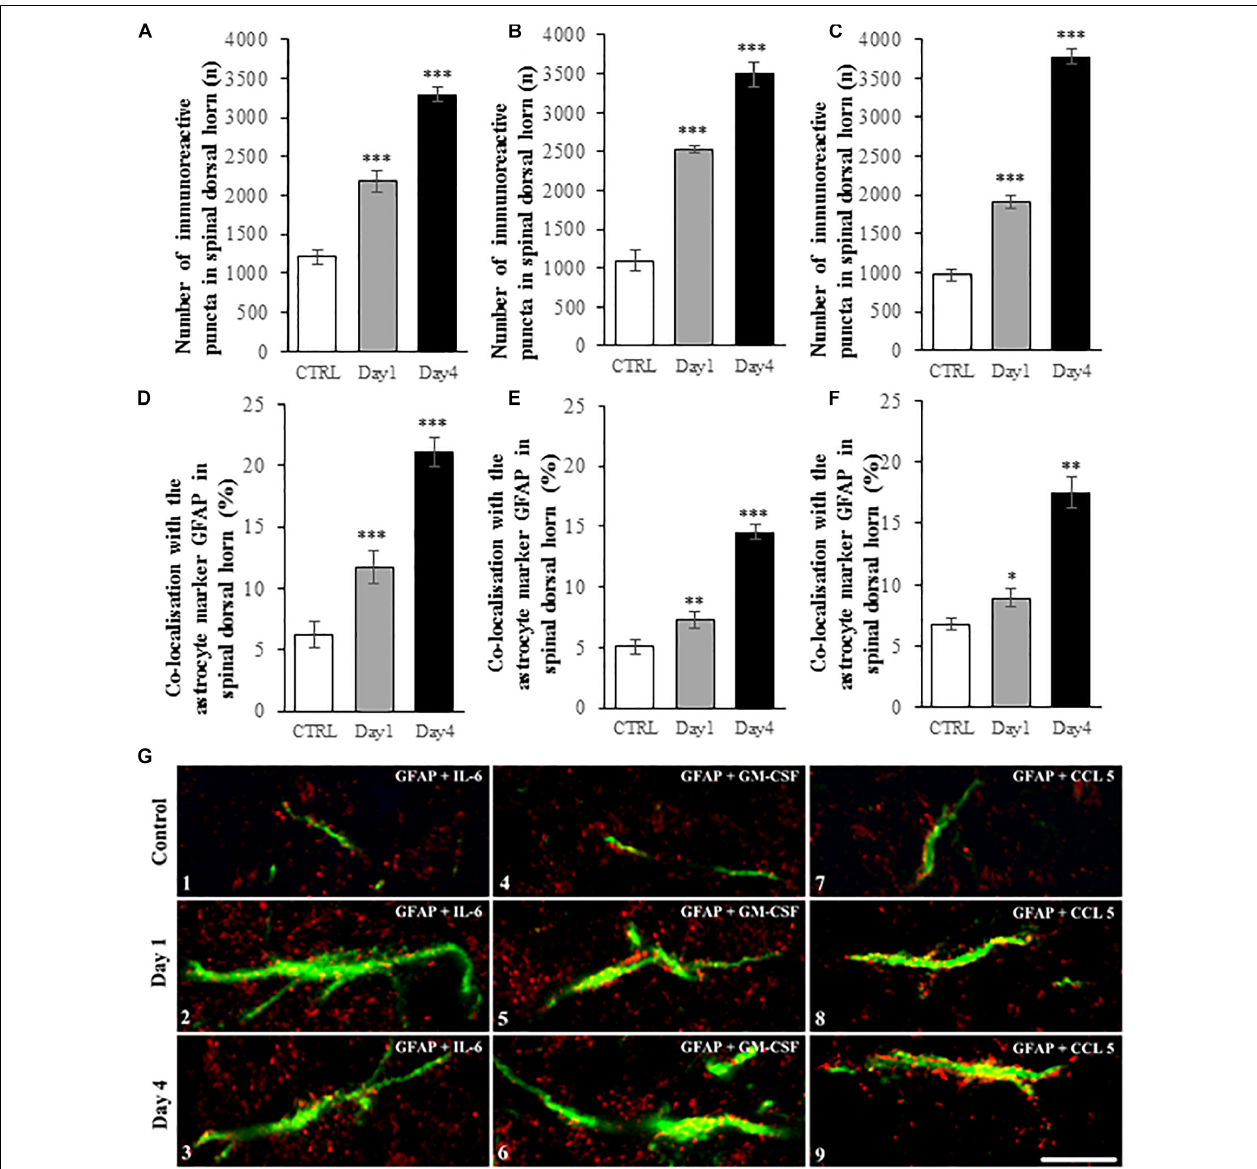
FIGURE 7 | IMARIS analysis of spinal cord sections show enhanced expression IL-6, GM-CSF, and CCL5 and increased co-localization of the cytokines with GFAP astrocyte marker during the course of CFA-evoked inflammatory pain. (A–C) Histograms show significant elevation of IL-6 (A) , GM-CSF (B) and CCL5 (C) immunoreactive puncta in spinal dorsal horn on post-injection days 1 and 4. Data are shown as mean ± SEM of five randomly selected spinal cord specimen (ANOVA, followed by Tukey’s pairwise comparison *** p < 0.001 versus control group). (D–F) Bar charts represent the ratio of co-localization between the IL-6 (D) , GM-CSF (E) and CCL5 (F) cytokine and GFAP in control and treated (on post-injection day 1 and 4) spinal cord specimen. Data are shown as mean ± SEM of five randomly selected spinal cord specimen. (Kruskal-Wallis statistical probe, followed by Mann-Whitney pairwise comparison ∗ p < 0.05, ∗∗ p < 0.01, ∗∗∗ p < 0.001 versus control group). (G) Representative high magnification superimposed confocal images of GFAP + astrocyte profiles (green) and IL-6 (red, G.1-3), GM-CSF (red, G.4-6) and CCL5 (red, G.7-9) immunoreactive puncta. First row of images (G.1, G.4, G.7) represents control specimen. Second (G.2, G.5, G.8) and third (G.3, G.6, G.9) rows show specimen on post-injection day 1 and 4, respectively. Mixed color (yellow) indicates co-localization of the markers. Scale bar: 10 µ